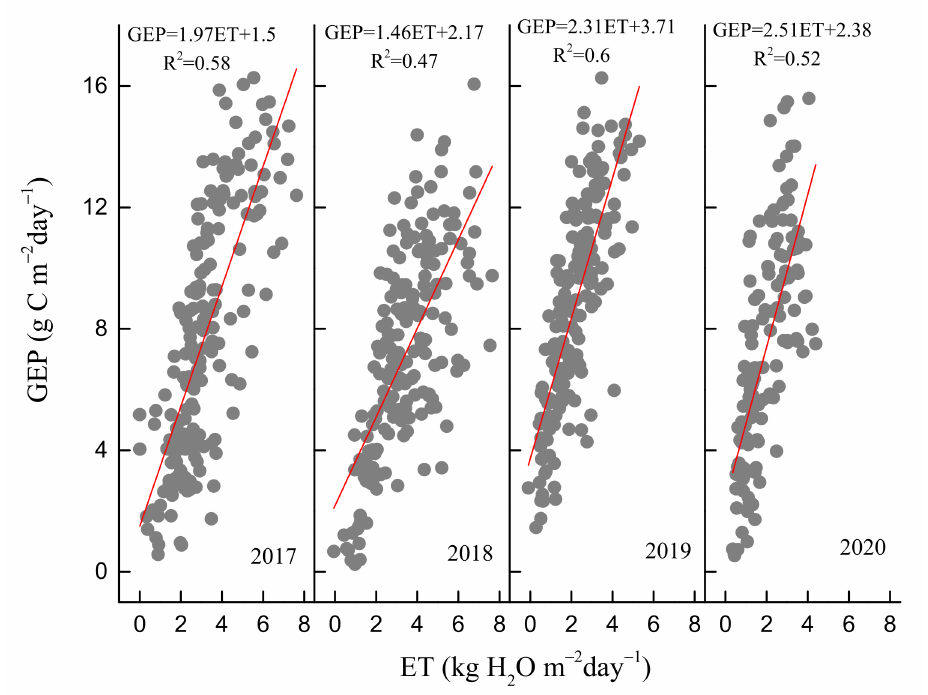
Figure 6. Relationship between daily gross ecosystem productivity (GEP) and evapotranspiration (ET) during the growing seasons from 2017 to